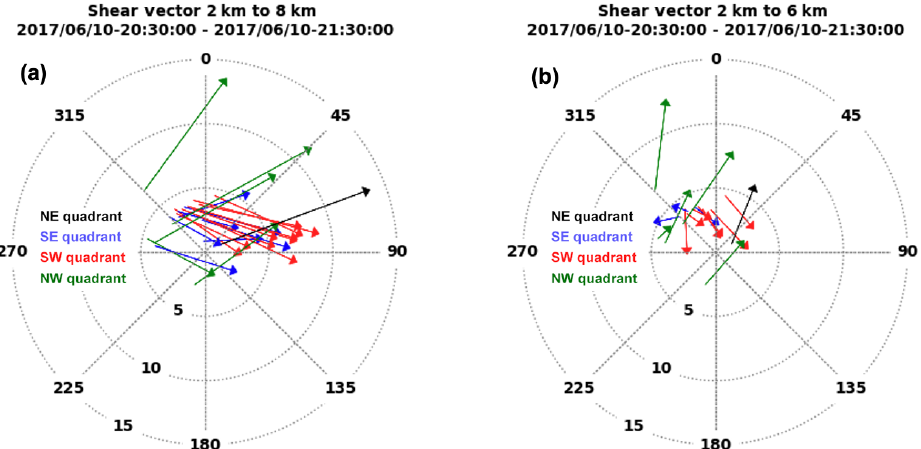
Figure 14. Same as Fig. 5, but for flight segment 3 (20:30–21:30UTC).